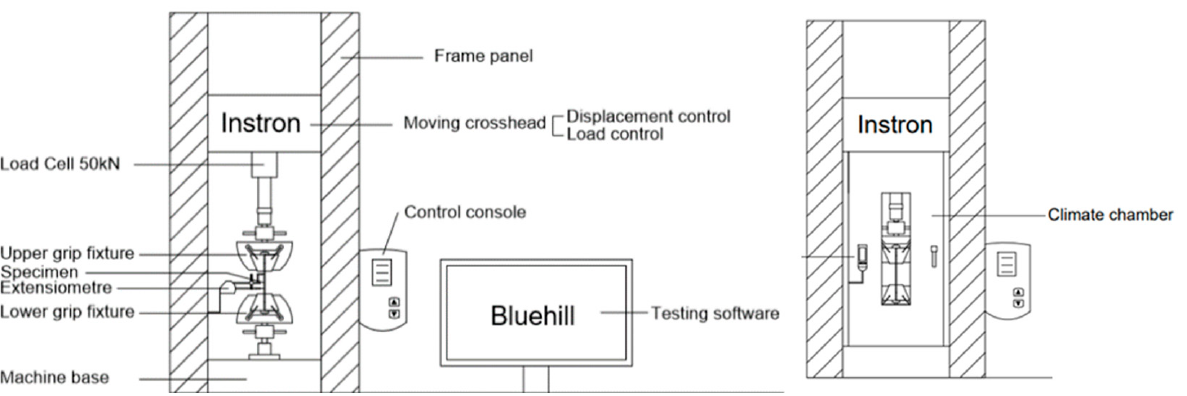
Figure 2. Sketch of experimental setup for room temperature and for elevated temperatures [38].